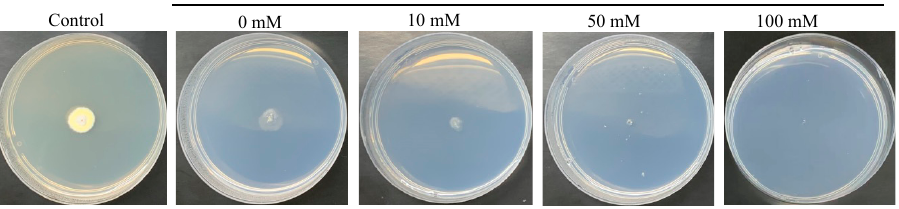
Figure 5. Growth of Spiromastix sp. SCSIO F190 on ANM plate with acetamide as sole nitrogen and carbon source. The spores of Spiromastix sp. SCSIO F190 were inoculated on the acetamide plate with different concentrations of cesium chloride and incubated at 28 °C for 10 days. The growth on the ANM plate containing glucose and ammonium tartrate was set as control.